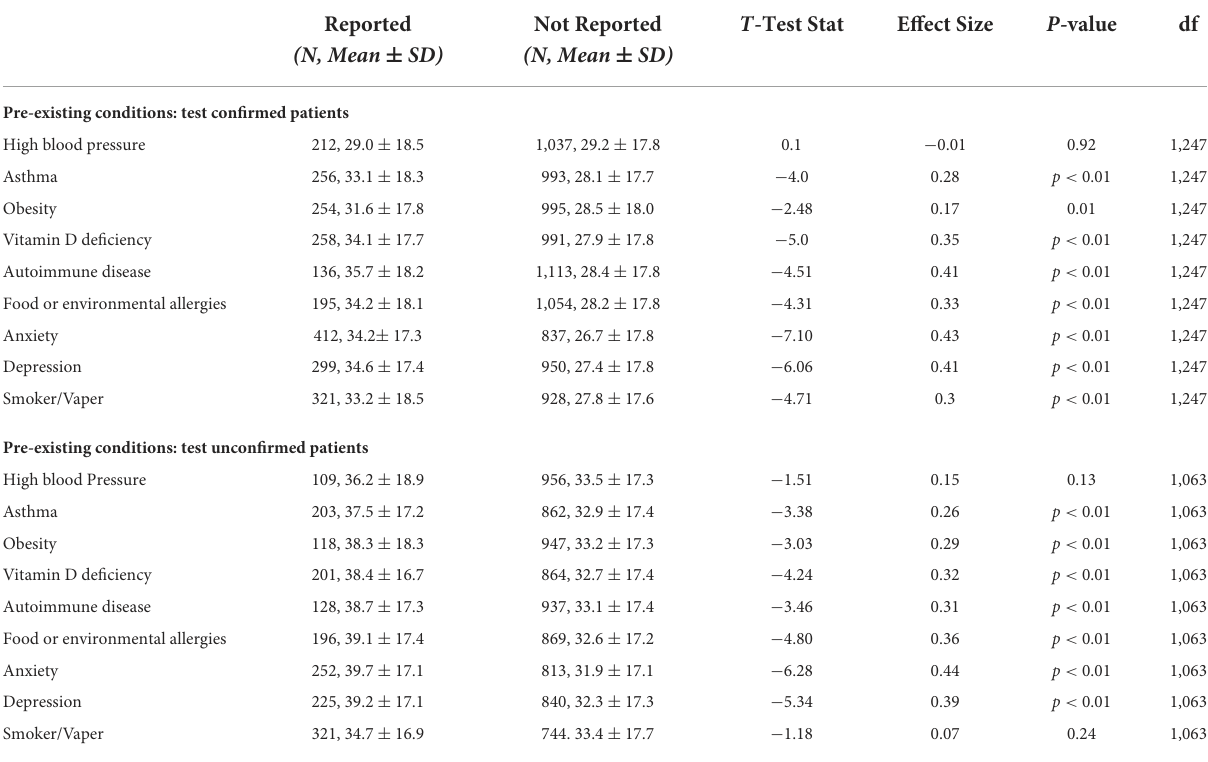
TABLE 3 Impact of medical conditions on autonomic symptom